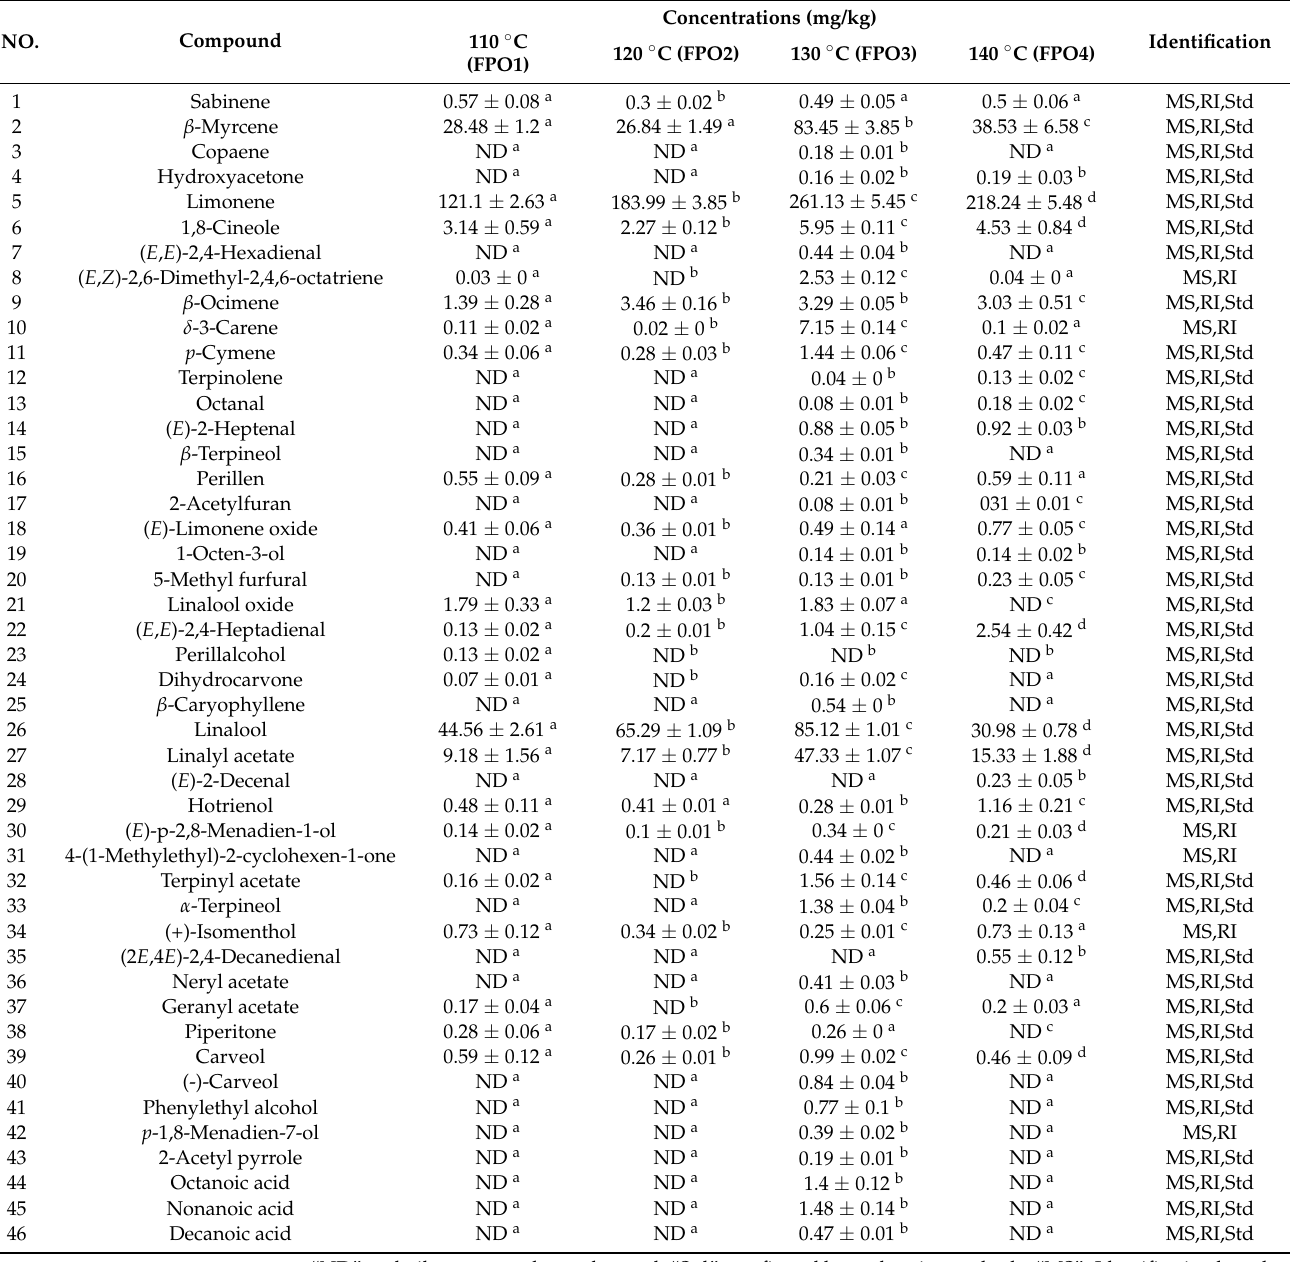
Table 1. Volatile compounds of pepper oil prepared at different frying temperatures by